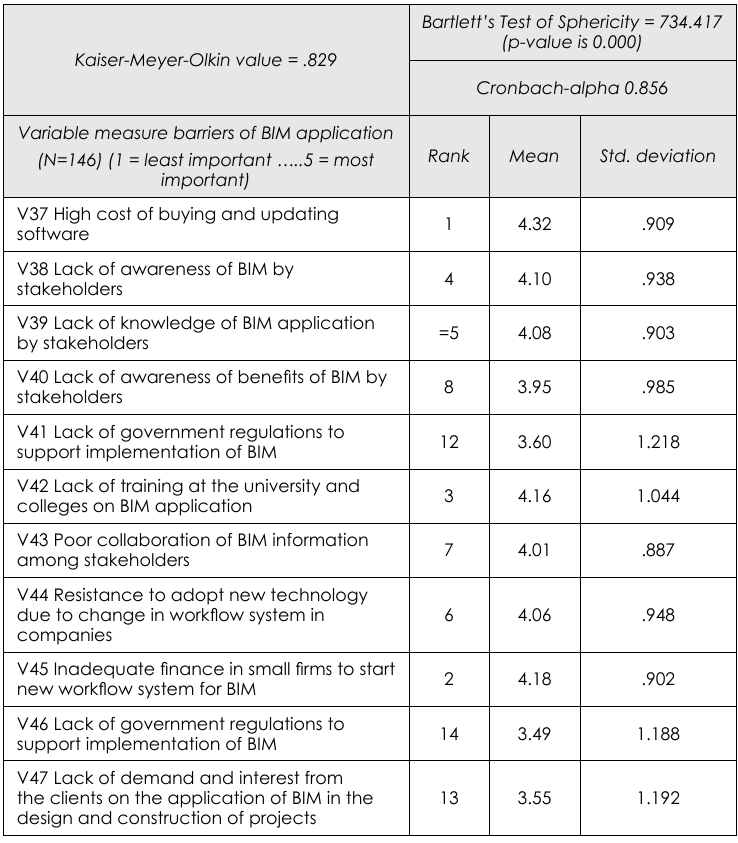
Ranking of barriers in implementing